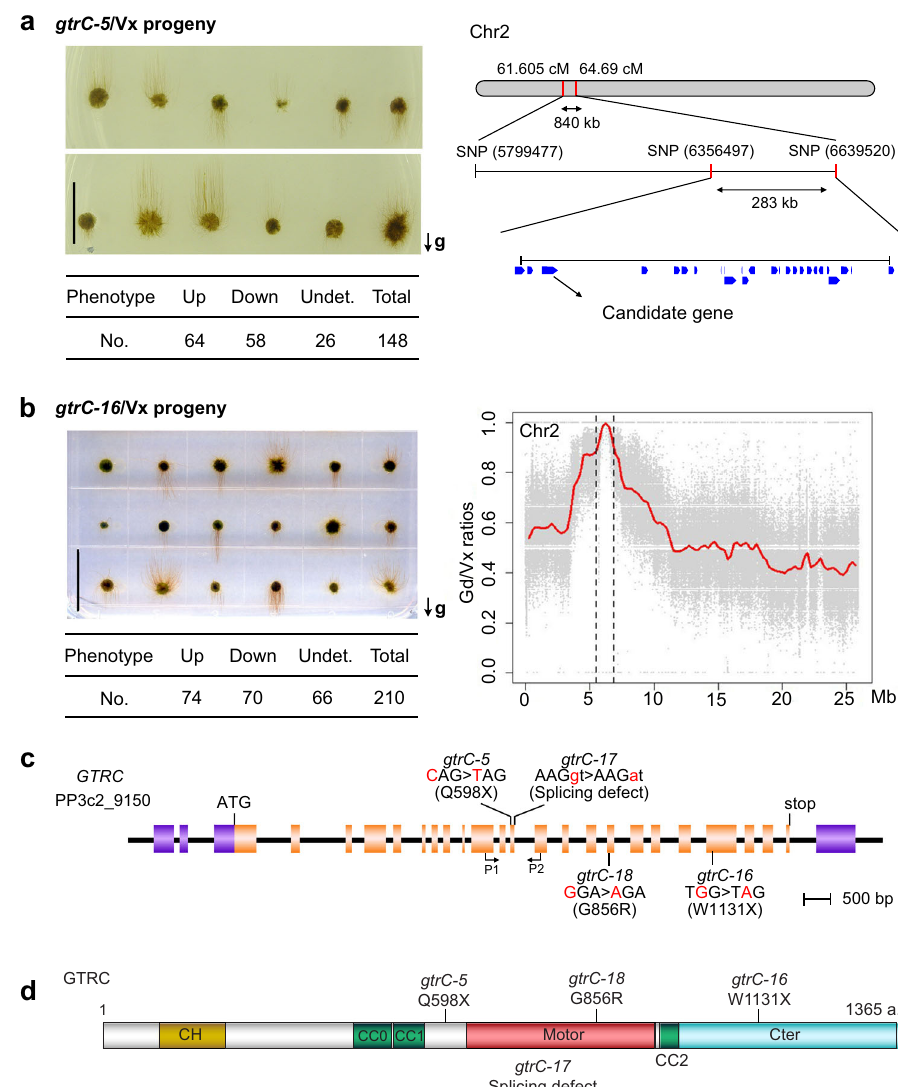
Fig. 2 Genetic mapping of the GTRC locus. a Mapping the gtrC-5 mutant. Left, segregants from a gtrC-5 /Vx hybrid spore capsule. Right: The genetic interval containing the gtrC-5 locus was identi fi ed to a 840 kb region (GoldenGate: between 61.605 and 64.69 cM,) in the fi rst round of mapping, and reduced to the interval of 283 kb distance in the second round of manual genotyping. A candidate gene with a nonsense mutation was identi fi ed in this reduced interval. Source data are provided as a Source Data fi le. b Mapping the gtrC-16 mutants. Left, segregants from gtrC-16 /Vx hybrids. Right, Gd/Vx SNP ratios in chromosome 2 derived from 48 gtrC-16 /Vx hybrid progeny whose protonemata grew downwards. They were mixed and DNA was extracted for whole-genome sequence. Red lines are plots of mean values of Gd/Vx SNP ratios in a 0.5 Mb region with the sliding window set to 0.25 Mb. A candidate gene with nonsense mutation was identi fi ed. Source data are provided as a Source Data fi le. In a , b , the arrows with “ g ” show the direction of the gravity vector. The segregants were divided into three groups based on the growth direction of dark-grown protonemata: Up, Down, or Undetermined (Undet.). Scale bars, 10 mm. The numbers (No.) of each phenotype were shown in the tables below each image. c Gene structure and mutation sites of the GTRC locus. Purple box, untranslated region; orange box, coding exons. X indicates stop codon. d Protein structure and the mutation sites of GTRC. X indicates stop codon. Brown box, CH domain; green box, coiled coil region predicted by COILS program; red box, motor domain; blue box, C terminus of KCH The gene Pp3c2_9150 encodes a motor-domain protein PpKCHb/Kinesin 14-IIb 29,30 (Fig. 2d). Targeted mutagenesis of the Pp3c2_9150 locus in wild type to produce the mutation present in gtrC-5 was carried out. Four additional (silent) bases were altered in order to facilitate discrimination between WT and mutant sequences by allele-speci fi c PCR (Fig. 3a). Those lines successfully converting the amino acid Q 598 to a stop codon resulted in a downward-growing gtrC phenotype, supporting the identi fi cation of this gene as a determinant of the gravitropic response (Fig. 3b – d). Further independent mutant alleles GTRC-